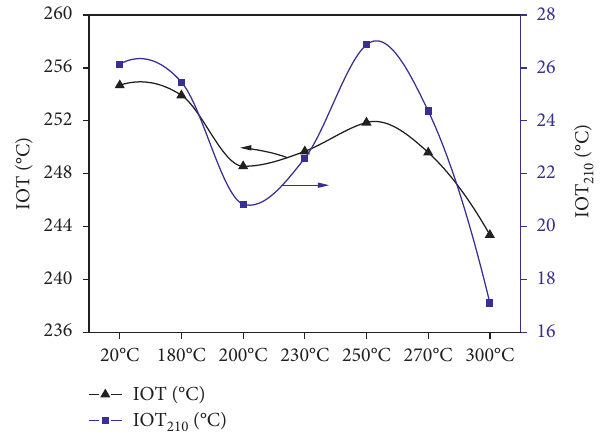
Figure 7: IOT and OIT values of oil samples.